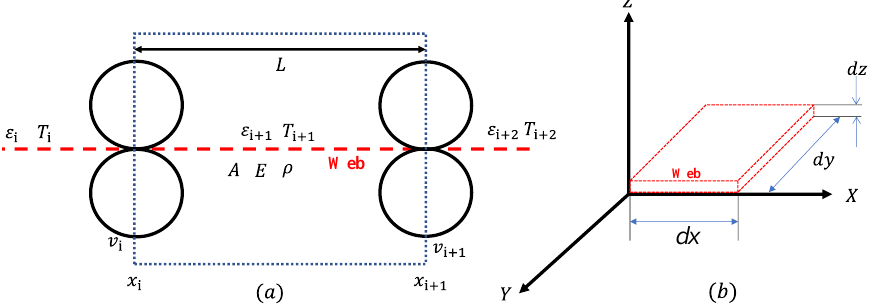
Figure 2. Schematic diagram of the web tension model in the R2R system: ( a ) 2-dimension of the web tension model, and ( b ) 3-dimension of the web tension